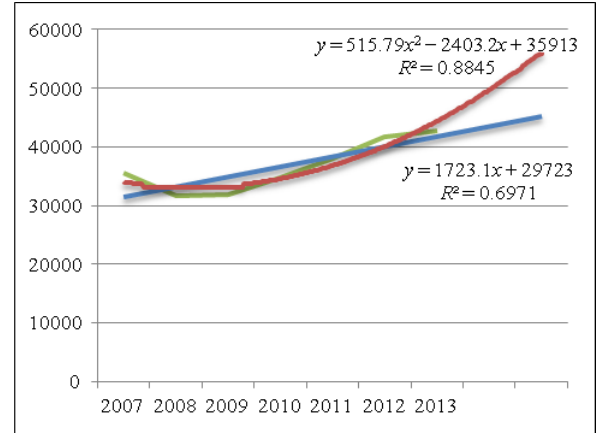
Fig. 1. FDI prognostication in Lithuania (compiled by the author with reference to the calculation results). The rising curve of FDI shows the trend of FDI